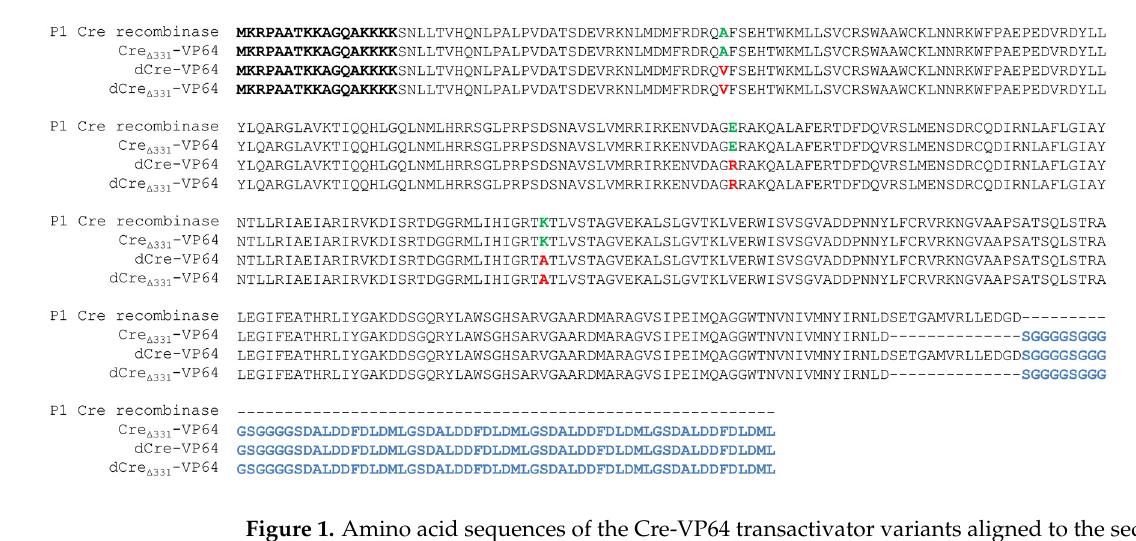
Figure 1. Amino acid sequences of the Cre-VP64 transactivator variants aligned to the sequence of the native P1 Cre recombinase. The NLS sequence is highlighted in bold. The VP64 transactivation domain with the S(GGGGS) 3 linker is highlighted in blue. Amino acid substitutions in catalytically and synaptically deficient mutant variants are highlighted in red, and the corresponding amino acids in the native sequence are highlighted in green.